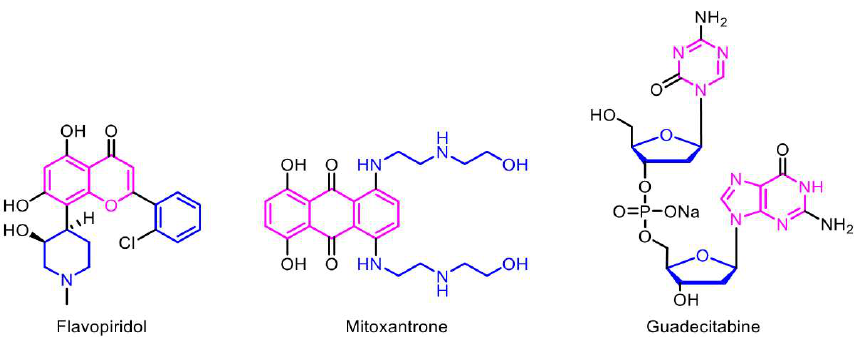
Figure 4. Selective and non-selective drugs for acute myeloid leukemia (AML). Different classes of drugs have been used for the treatment AML, which can be further classified as selective (e.g., flavopiridol) and non-selective drugs (e.g., mitoxantrone and guadecitabine), based on their targets and their mechanisms of action (MOA).